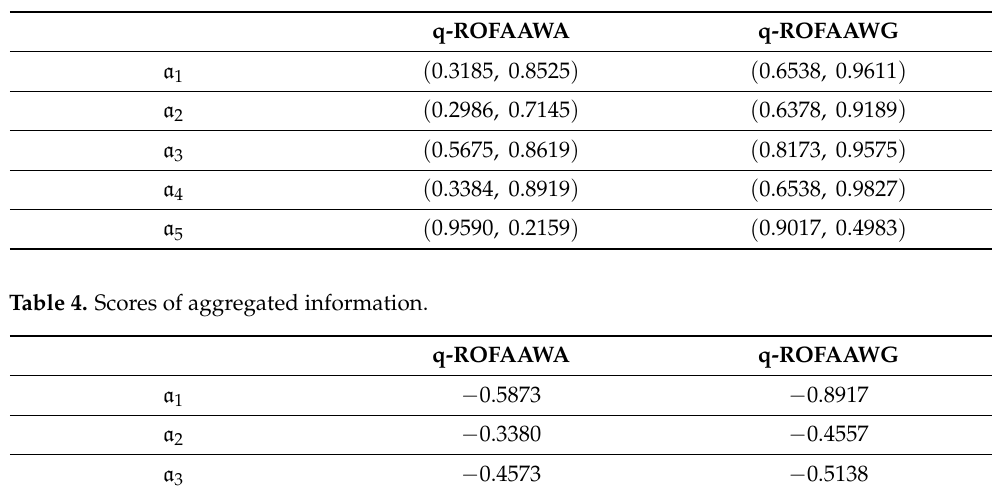
Table 3. Aggregation findings by using proposed q-ROFAAWA and q-ROFAAWG operators.